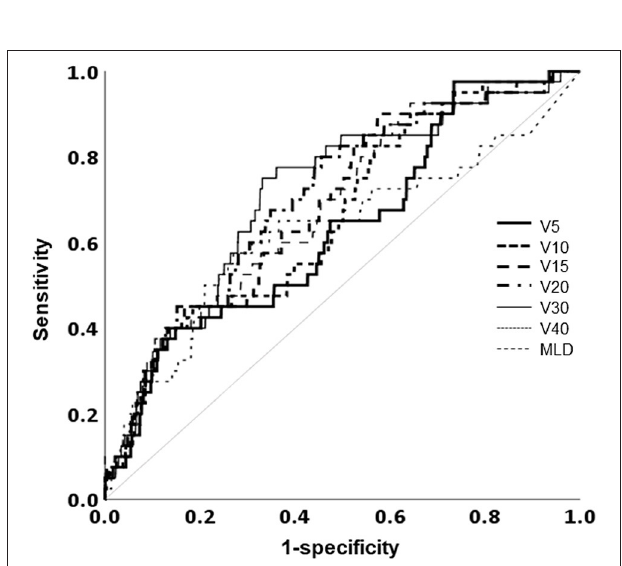
FIGURE 4 | Receiver operating characteristic curve analysis for the optimal cutoff value to predict the occurrence of radiation pneumonitis. MLD, mean lung dose; V χ , percentage of the total volume exceeding χ